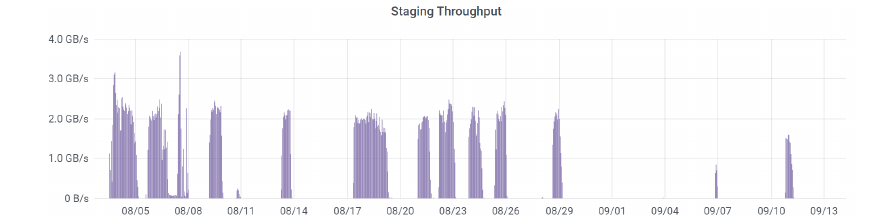
Figure 2: Staging throughput (GB / s) from a single Tier-1 (RAL) during the reprocessing campaign, which clearly shows the wave-like staging pattern.